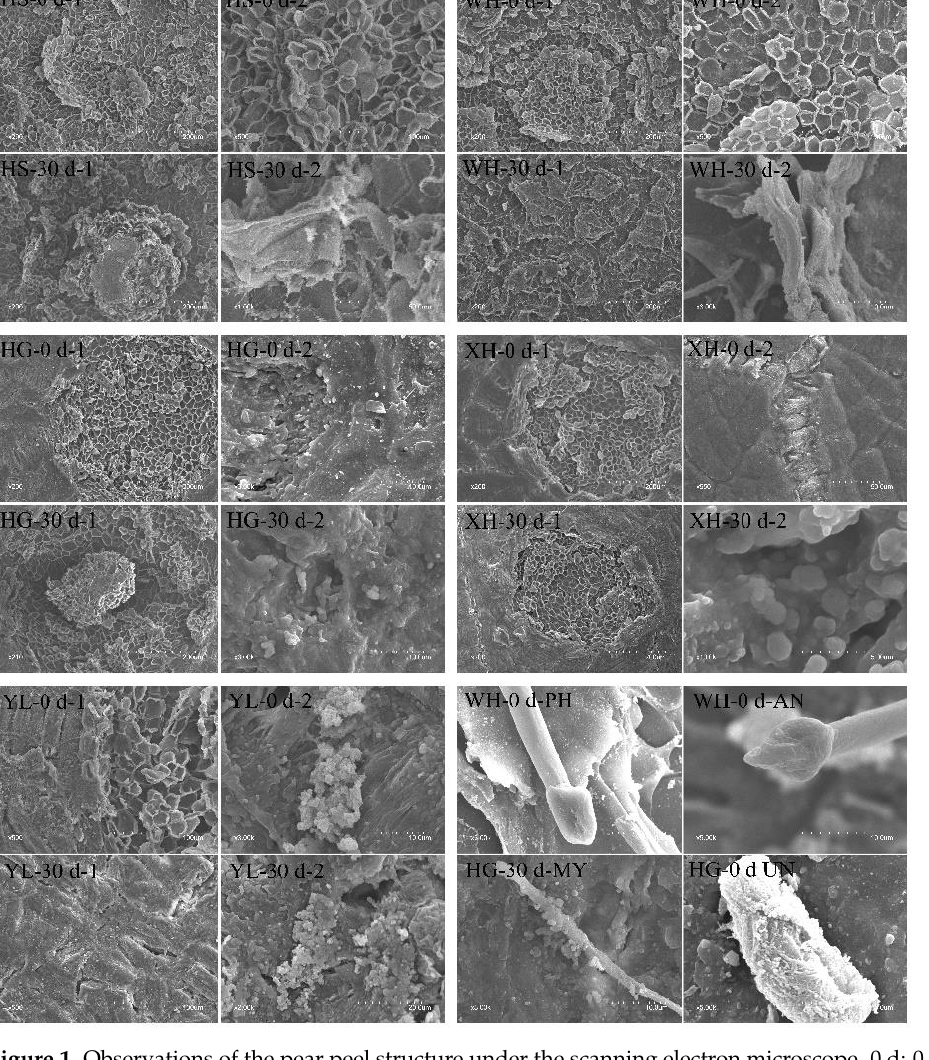
Figure 1. Observations of the pear peel structure under the scanning electron microscope. 0 d: 0 d of shelf life, 30 d: 30 d of shelf life; PH: sporophore; AN: sporangium; MY: hypha; UN: unknown impurity.